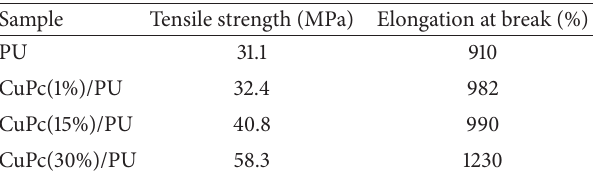
Table 2: Mechanical properties of PU and CuPc/PU composites. Sample